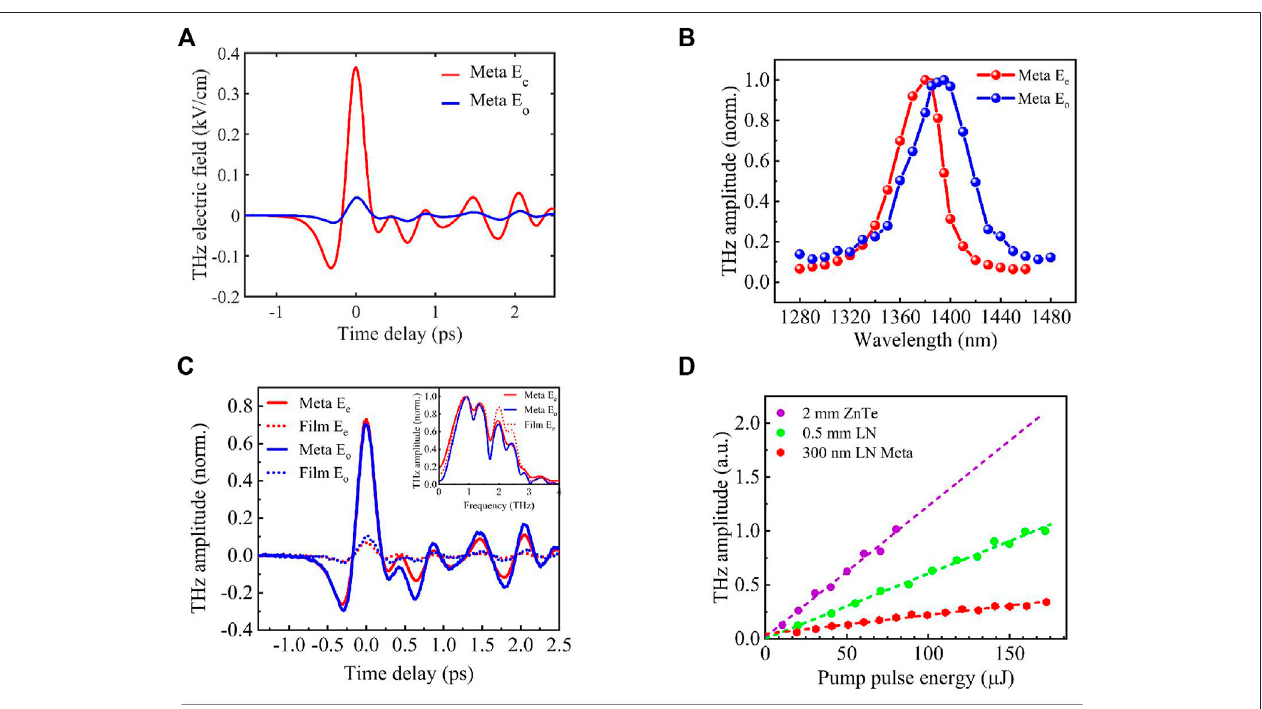
FIGURE 3 | Enhanced THz generation from the LiNbO 3 metasurface. The polarization of THz and pump pulses is along the z -axis. (A) Anisotropic THz waves with respect totheorientationoftheopticalaxis.TheextraordinaryTHzwaves(E e ,red) withtheopticalaxisarealongthe z -axis, andtheexcitationwavelengthof1,375 nmis eighttimeslargerthantheamplitudeofordinaryTHzwaves(E o ,blue)withtheopticalaxisalongthe y -axisandtheexcitationwavelengthof1,395 nm. (B) Selectivityofthe excitation wavelength is due to the resonance in the LiNbO 3 metasurface. Normalized THz peak-to-peak electric fi eld with extraordinary (E e , red) and ordinary (E o , blue) polarization by tuning the pump wavelength. (C) Enhancement of THz generation in the LiNbO 3 metasurface (solid line) compared with the unstructured LiNbO 3 nano fi lm(dotted)ofthesamethickness.Theextraordinary(E e ,red)andordinary(E o ,blue)THzwavesaregeneratedwiththeresonantexcitationwavelengthat1,375 nm and 1,395 nm, respectively. E e and E o are normalized by the resonantly enhanced THz waves from the LiNbO 3 metasurface, respectively. The normalized Fourier contents of the THz electric fi eld are shown in the inset. (D) Dependence of the THz electric fi eld on the pump energy generated from 2-mm thick ZnTe (violet), 0.5-mm thick LiNbO 3 crystal wafer (green), and the 300-nm thick LiNbO 3 metasurface (red). The dashed line is the line fi tting the experimental